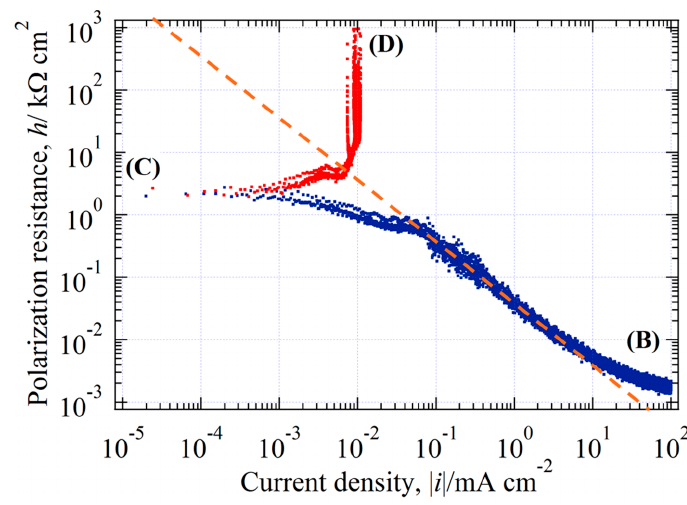
Figure 2. Polarization resistance curve, h exp ( i ) obtained by differentiating the E exp ( i ) shown in Figure 1. For reference, an orange broken line with gradient of dlog h /dlog | i | = − 1 is added. The (B), (C), and (D) correspond to that in Figure 1.